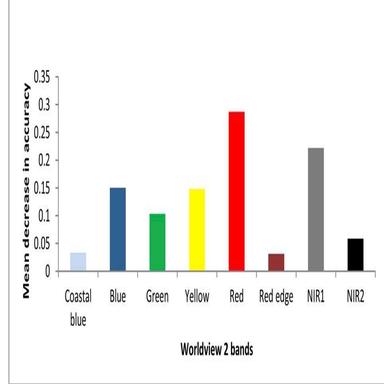
Histogram showing the overall importance of different WV2 bands in detecting the different land cover classes reported in